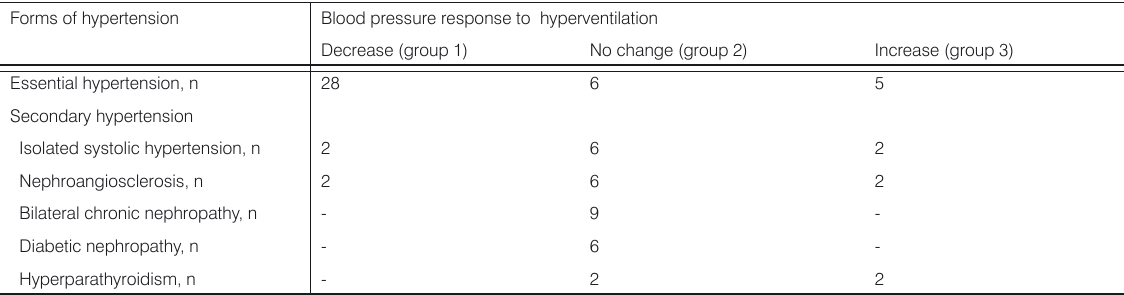
Table 3. Elderly hypertensive patients divided according to blood pressure response to